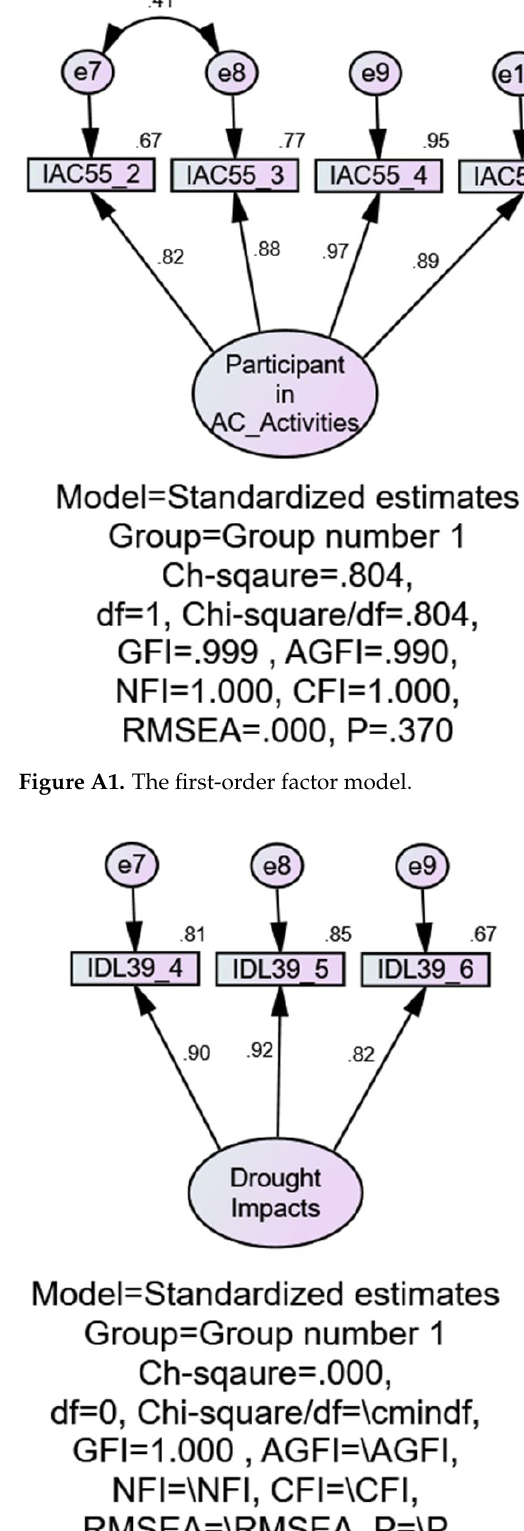
Figure A3. First-order factor model.